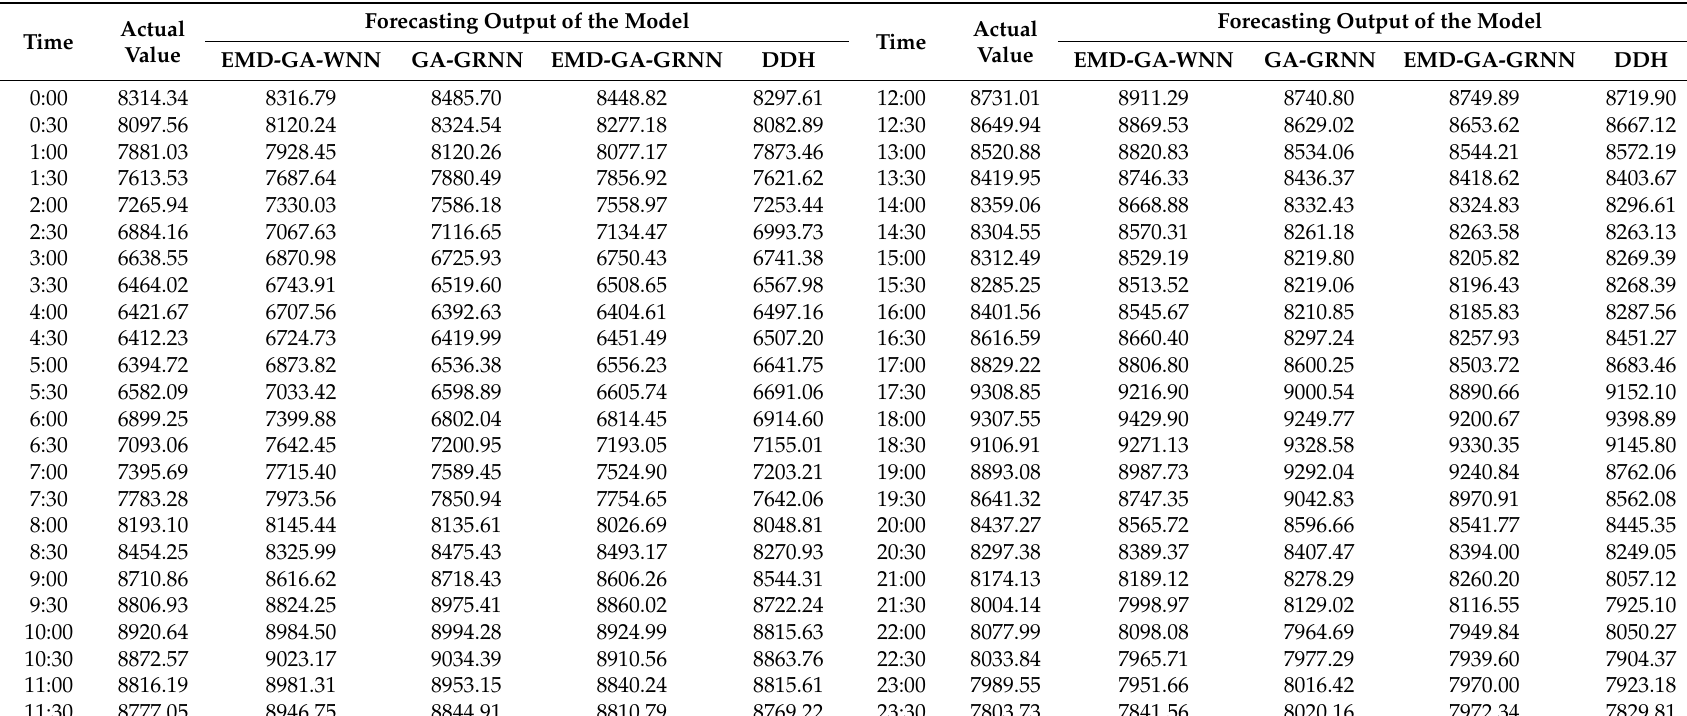
Table 2. The forecasting output of each